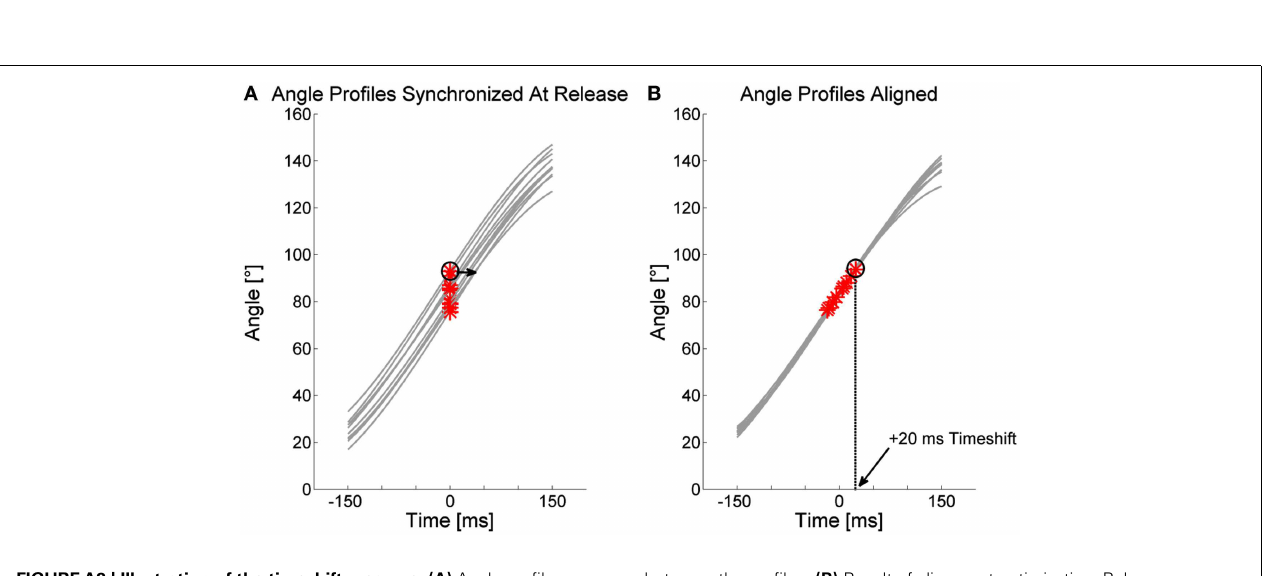
FIGUREA2 | Illustration of the timeshift measure. (A) Angle profiles of 10 trials are plotted for a window of 300ms around release and with their moments of release synchronized at time t = 0.The alignment procedure shifts angle profiles back and forth in time to reduce RMSE